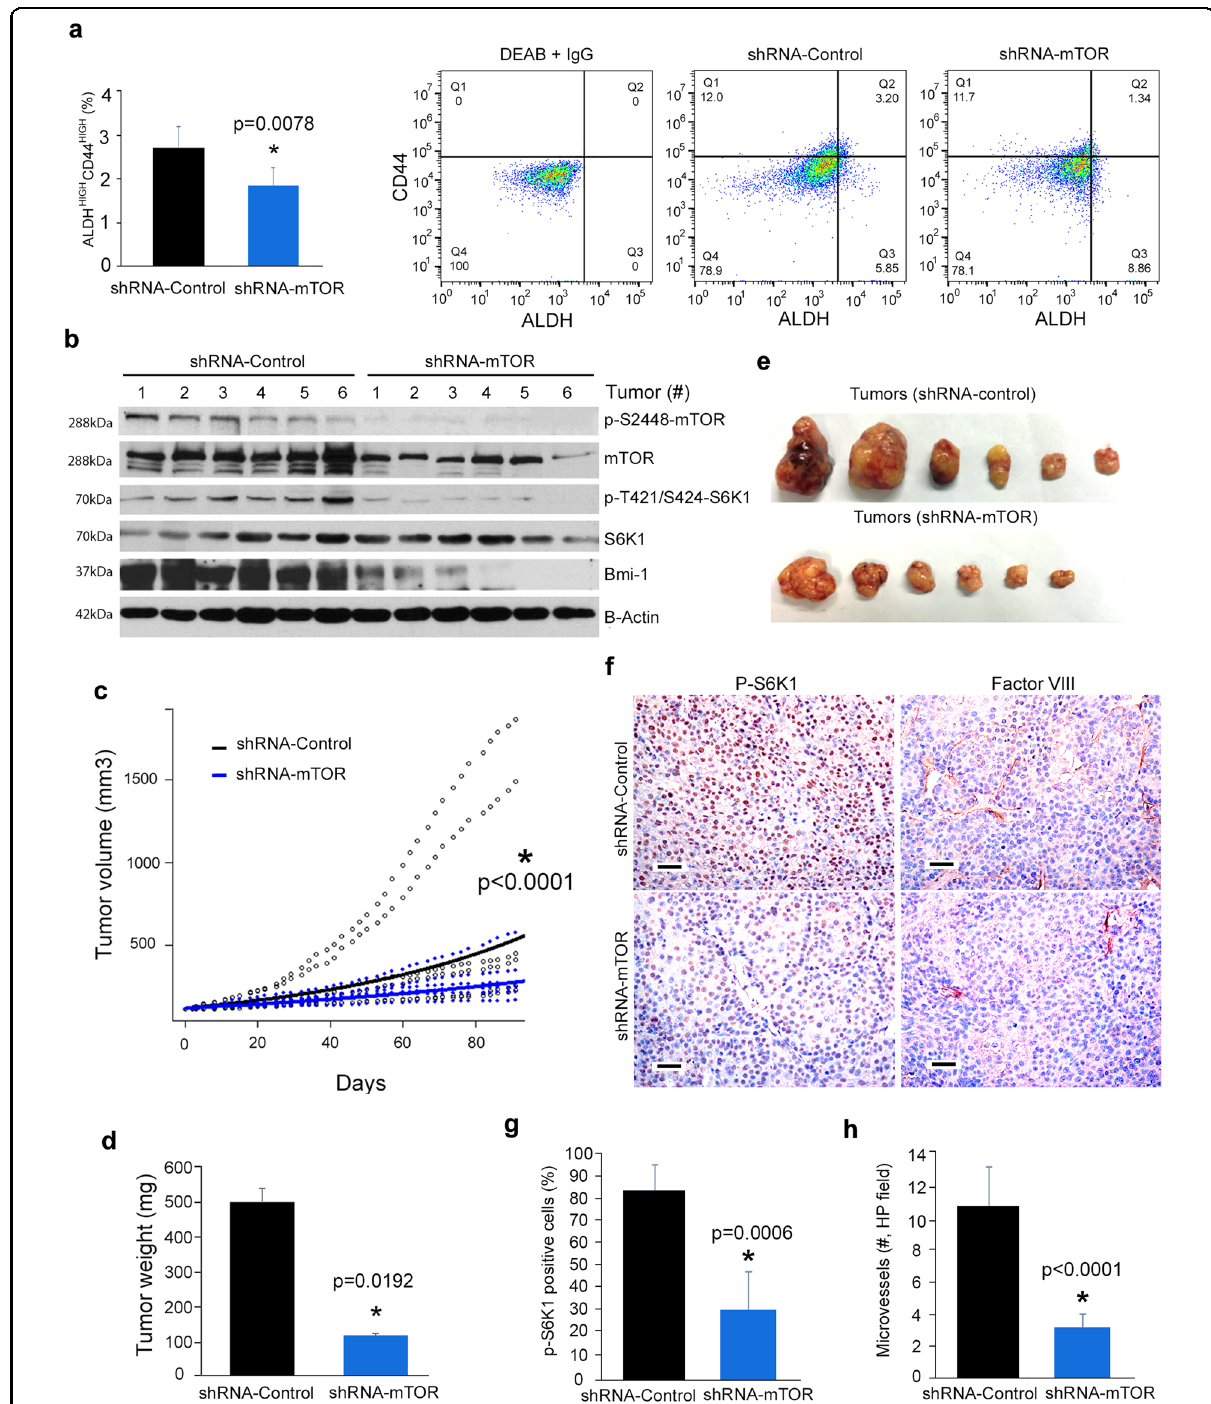
Fig. 6 (See legend on next